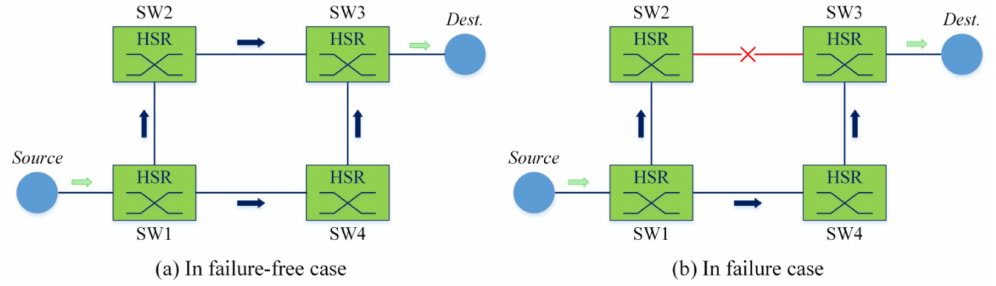
Figure 17. Redundancy provided by SwitchBox-based HSR.